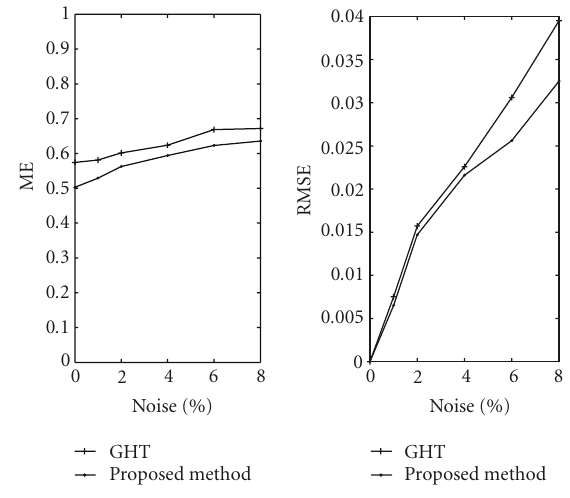
Figure 5: Mean value (pixels) and root mean square error (pixels) of the mean bias over the radius value, as a function of the percent- age of noisy